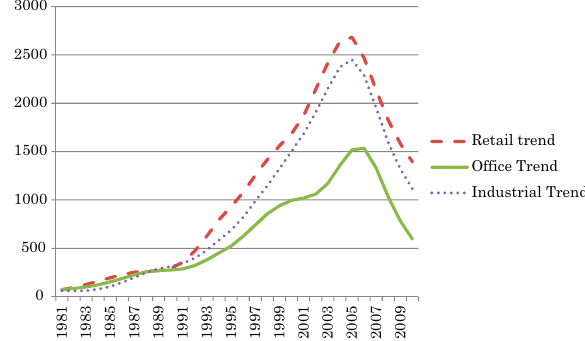
fig. 5. Trends in the real value of purchases based on HP filter ( λ = 6.25)